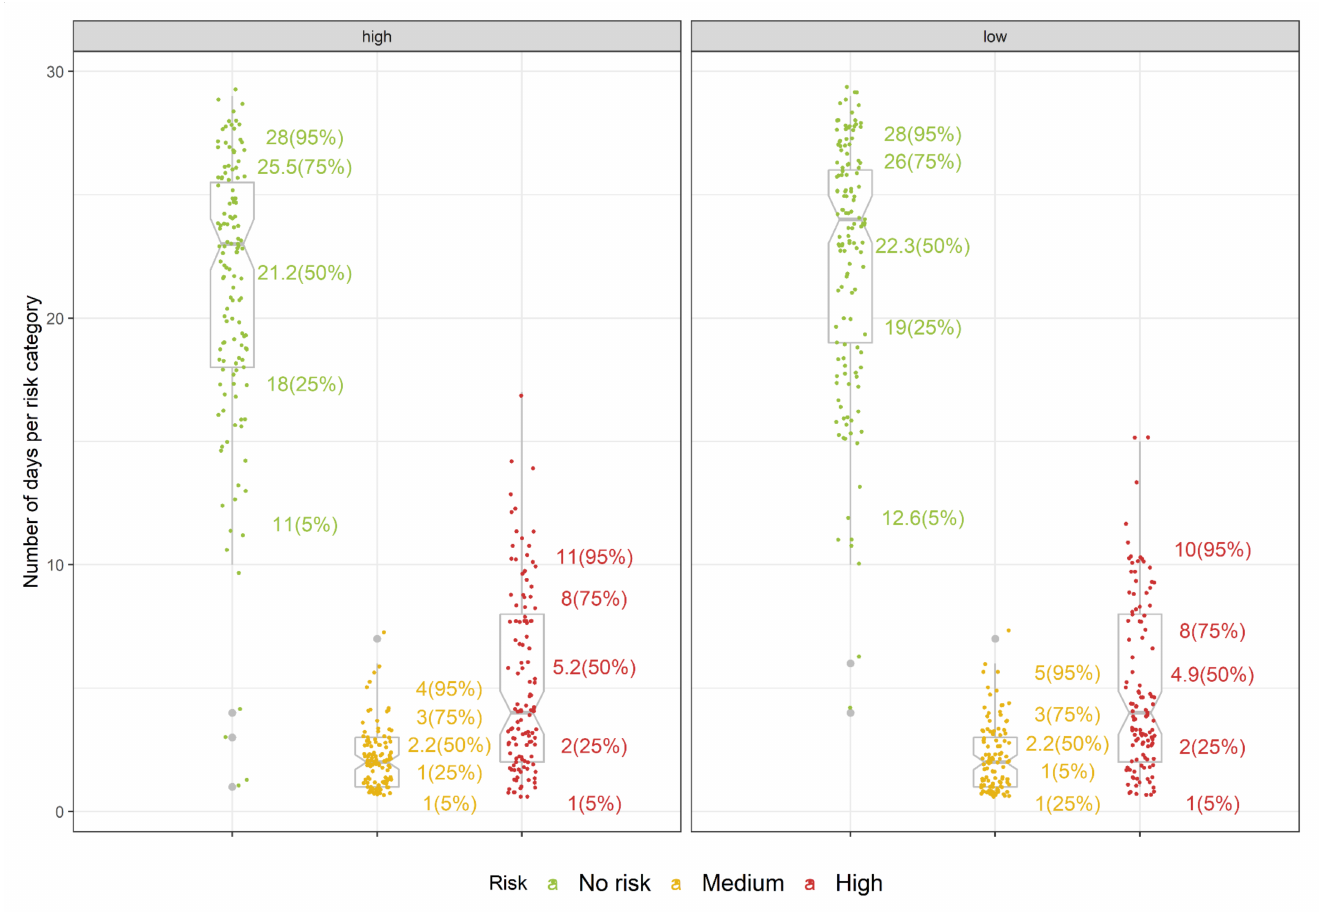
Figure 9. Initial evaluation of the mummy berry infection sub-model for blueberry in northwestern Washington. Individual points represent the number of days classified in the no-risk, medium and high-risk categories out of the four-week evaluation period, for high(left) and low(right) management levels. The numbers on the side of the grey box plots correspond to percentiles of the total sum per risk category. Grey dots represent the outlier